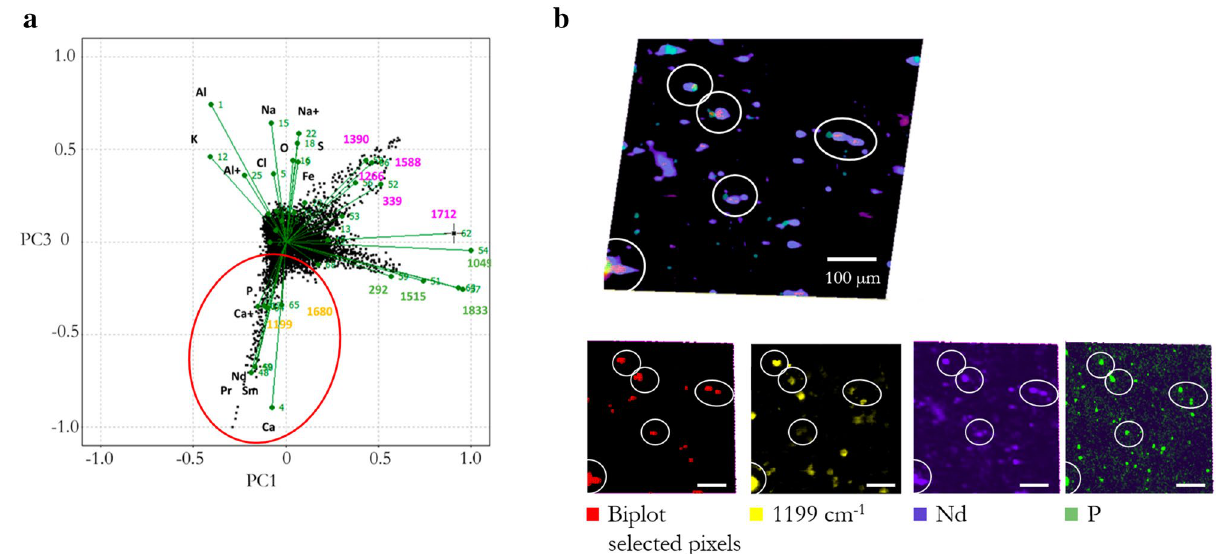
Figure 8. ( a ) PC1 vs PC3 scores-loading biplot of NU-A sample and ( b ) superposition of the spatial distribution of selected pixels (red ellipse in a), Nd, P, and 1199 cm −1 Raman band. Individual distributions are included for better visualization. Main areas of coincidence are marked in white. Scale bar corresponds to 100